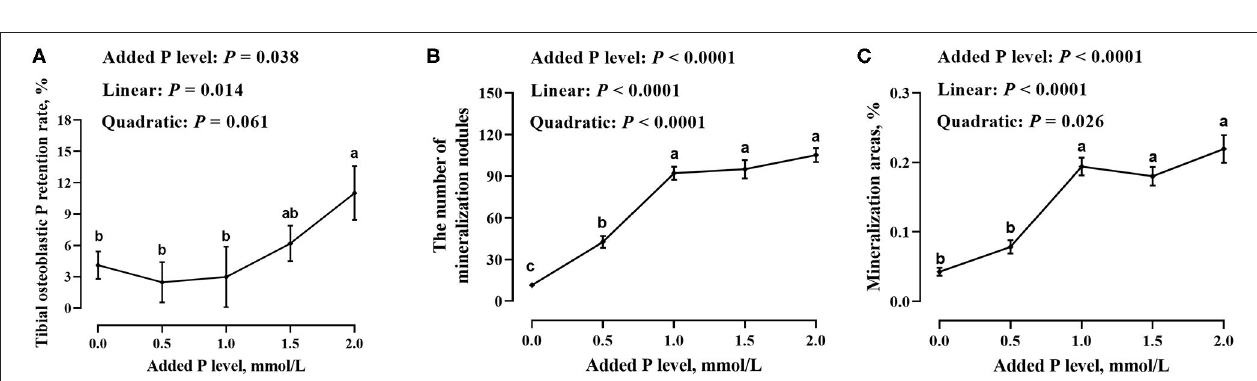
FIGURE 2 | Effect of added P level on tibial osteoblastic P retention rate (A) and number (B) and area (C) of mineralized nodules in primary cultured tibial osteoblasts of broiler chicks. Each value was mean ± SE, n = 6. Means without a common letter differ, p ≤ 0.05.